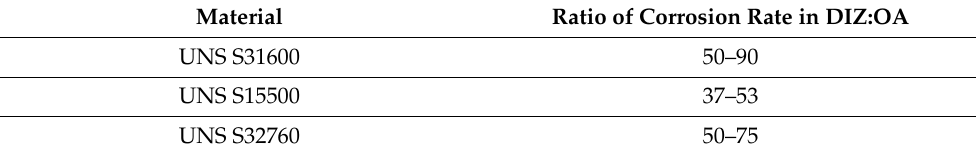
Table 10. Relative corrosion rates in DIZ and